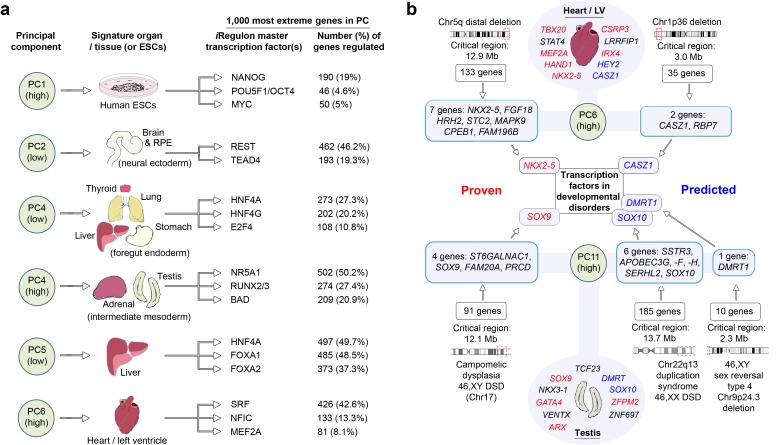
LgPCA points to master regulators of human organogenesis and the causes of human congenital disorders.(a) Predicted regulation by iRegulon (Janky et al., 2014) of the most extreme 1000 genes for different PCs identifies known and unexpected transcription factors regulating human organogenesis. In several examples, individual transcription factors (e.g. REST, NR5A1, HNF4A, FOXA1 and SRF) were predicted to regulate nearly half of the most extreme 1000 genes. (b) Transcription factors at the extremes of individual PCs in the LgPCA are responsible for a diverse range of congenital disorders (red names in the ovals for heart and testis; full details in Supplementary file 1G). To validate the utility of these data, we conservatively selected some of the earliest critical regions for these disorders (two ‘Proven’ examples on the left; all 53 listed in Supplementary file 1H). LgPCA frequently isolated the correct transcription factor from an average of 111 genes across >10 Mb, shown for NKX2-5 in congenital heart disease and SOX9 in campomelic dysplasia. Beyond this validation LgPCA similarly predicts causative transcription factors (blue) for many unresolved congenital disorders such as developmental heart abnormalities in Chr1p36 deletion syndrome and sex reversal / disorders of sex differentiation (DSD) (all 13 examples in Supplementary file 1H).